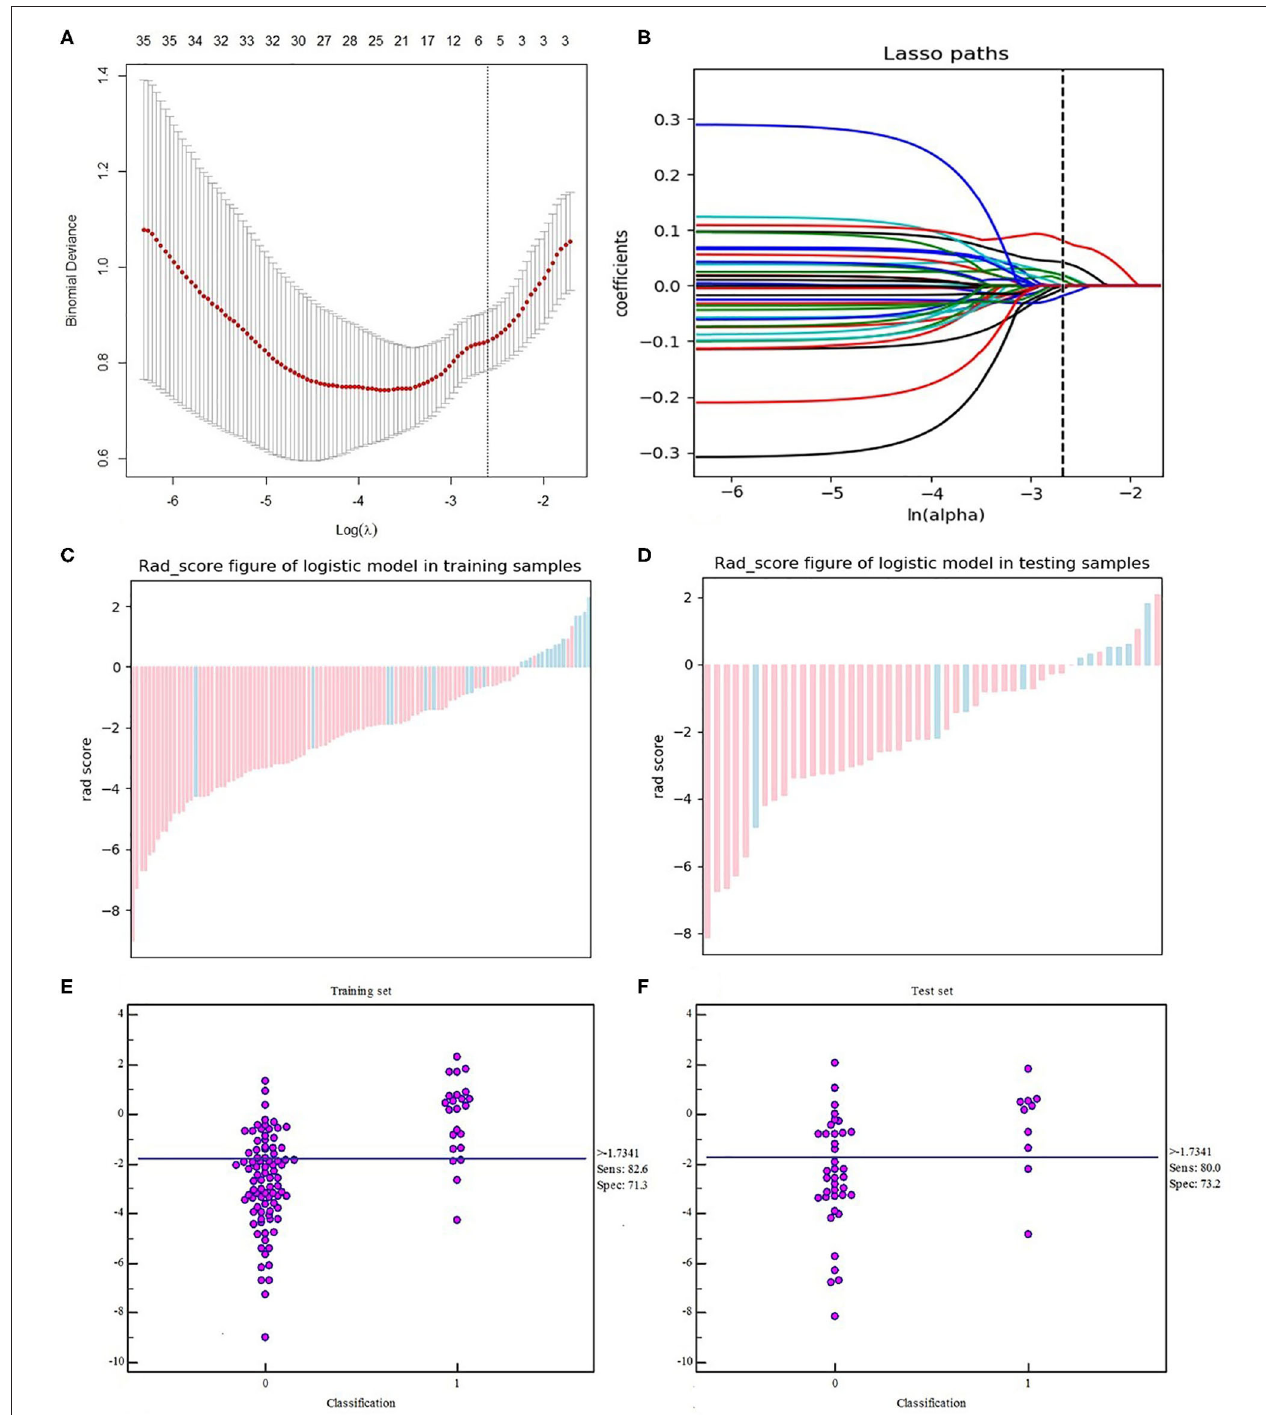
FIGURE 3 | Texture feature selection using the LASSO logistic regression. (A) The tuning parameter ( λ ) selection in the LASSO model used 10-fold cross-validation via the minimum criteria. Partial likelihood deviance was plotted vs. log ( λ ). The dotted vertical lines were drawn at the optimal values using the minimum criteria and the 1-SE criteria. (B) The LASSO coefficient profiles of the 35 texture features. The vertical line was drawn at the value selected using 10-fold cross-validation in the log ( λ ) sequence, and six features with non-zero coefficients are indicated. Score diagrams of the radiomics signature in the (C) training set and (D) test set. Red represents non-pCR and blue represents pCR. A score > 0 indicates pCR, and a score < 0 indicates non-pCR. Both panels (C,D) show interactive dot diagrams revealing the accuracy of the radiomics signature for predicting pCR in patients of the (E) training set and (F) test set. Zero represents non-pCR, and 1 represents pCR. The horizontal line indicates the best threshold point to distinguish patients with pCR from patients with non-pCR.